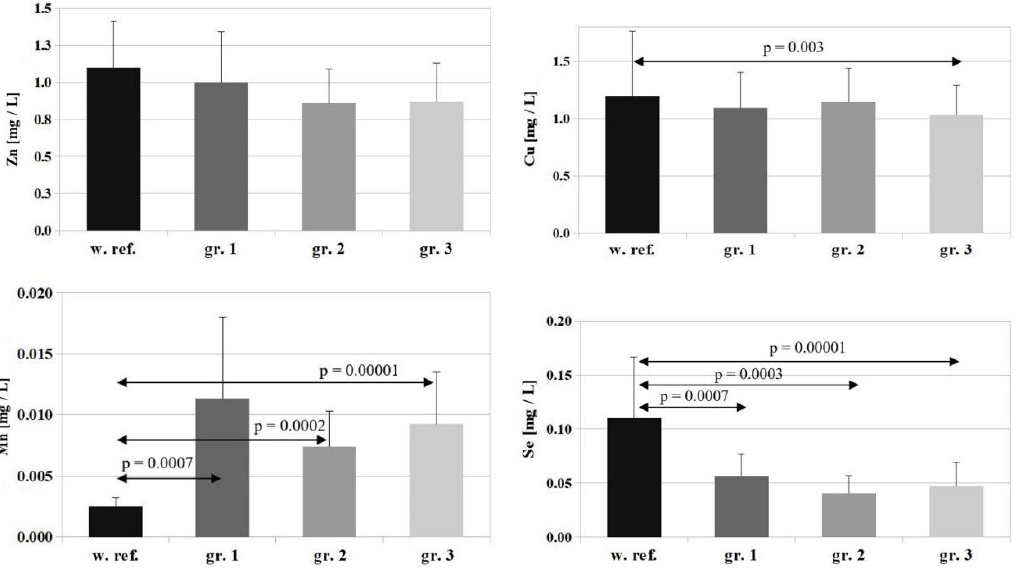
Figure 2. Comparison of reference values for Zn, Cu, Mn and Se and their concentrations in the serum of patients on the first day of hospitalization. w.ref. – reference value; gr – group serum of patients on the first day of hospitalization. w.ref.–reference value;